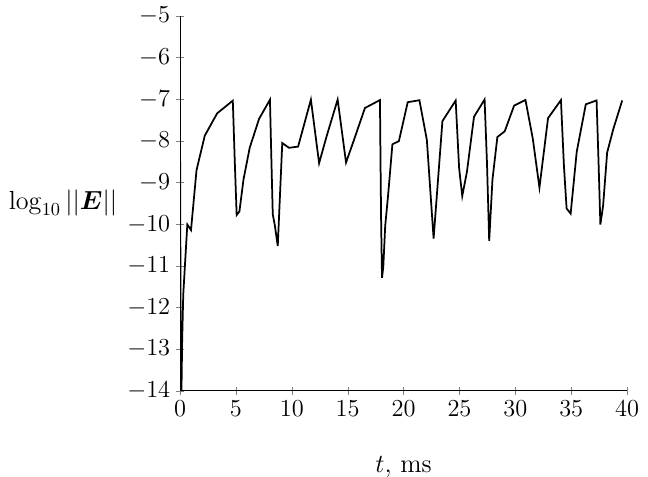
Figure 12. The decimal logarithm of the norm of the error vector estimated during the calculation process for the solution shown in Figure